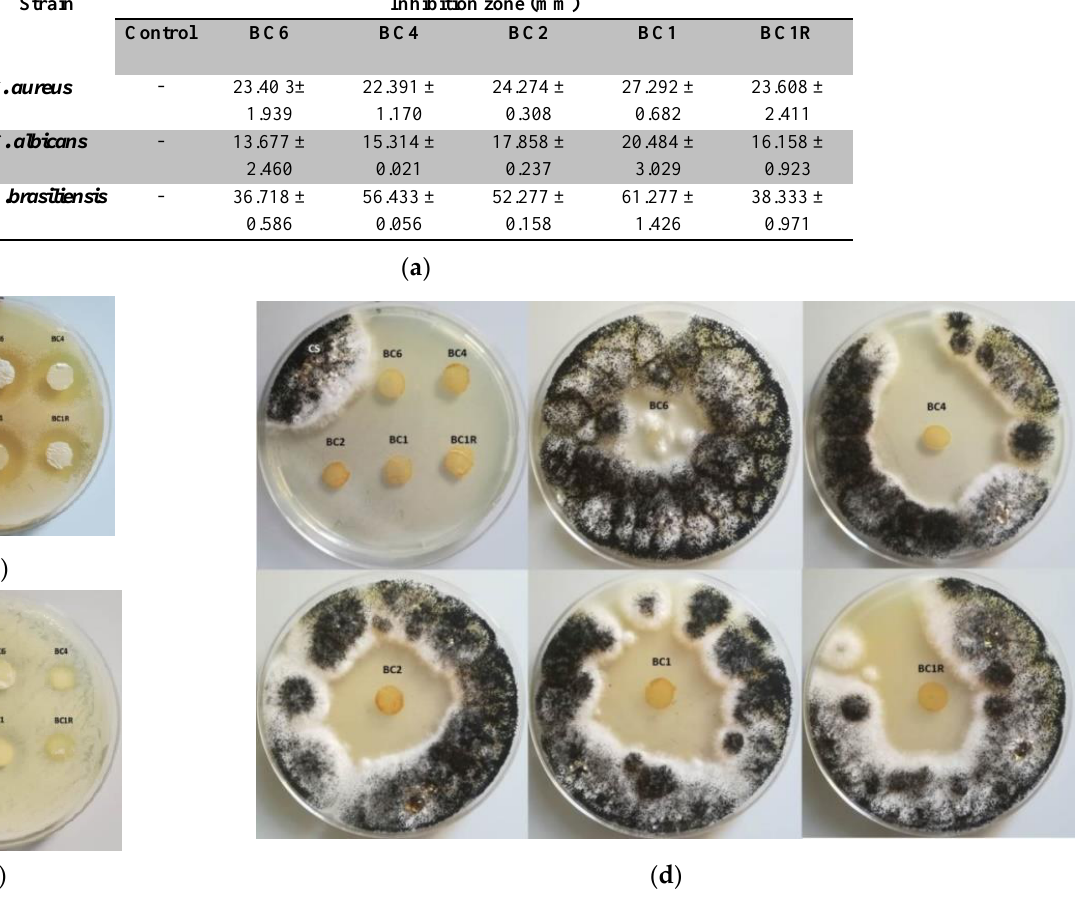
Figure 9. ( a ) Antimicrobial activity of the fiber mats, and representative images against ( b ) S. aureus , ( c ) C. albicans and ( d ) A. brasiliensis strains, (Due to the high activity against the A. brasiliensis , the tests were repeated by incubation of each sample in different Petri dish).